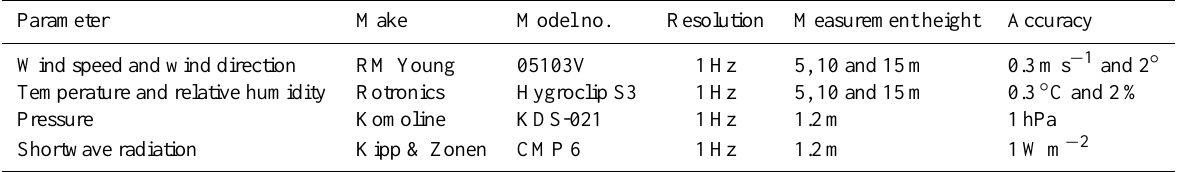
Table 2. Details of measured parameters and sensors (make, model number, resolution and accuracy) on MBLM. Parameter Make Model